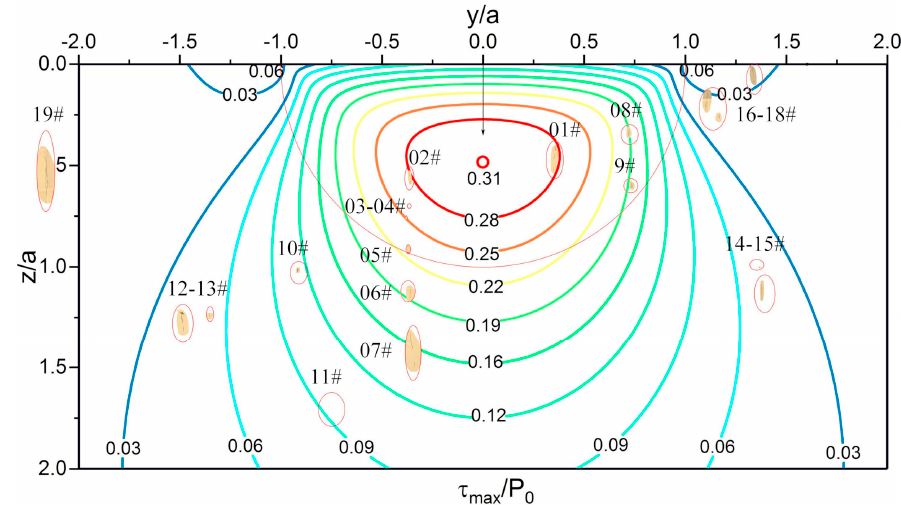
Figure 17. Composite image of inclusion positions and principal shear stress field in 0.0mm section of the plate specimen. Drawing of stress contours is based on Fu’s thesis [10]. For a point inside the material, y / a is the ratio of the horizontal distance (from the point to the contact center) to the contact radius, and z / a is the ratio of the depth to the contact radius.